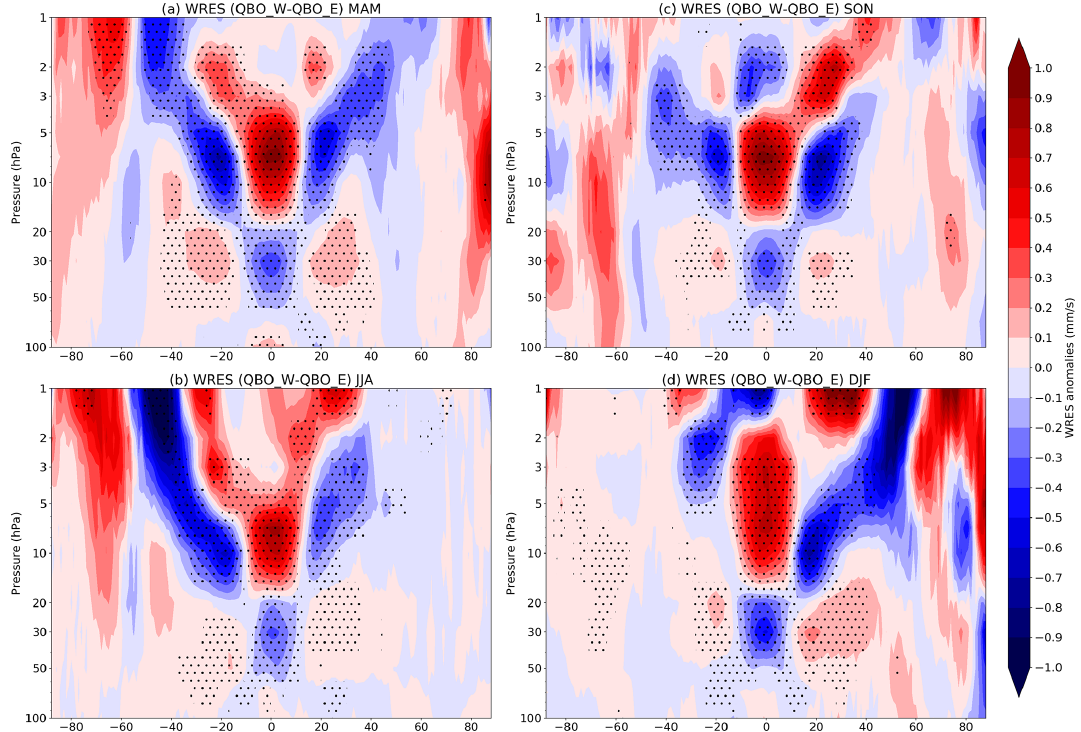
Figure 6. Latitude–height cross section of w ∗ (vertical component of the BDC) anomalies associated with QBO (QBOW–QBOE) from ERA5 data for the period 1985–2020. (a) MAM. (b) JJA. (c) SON. (d) DJF. Stippled areas indicate results that are statistically significant over the 95% level, using the two-tailed Student’s t test.